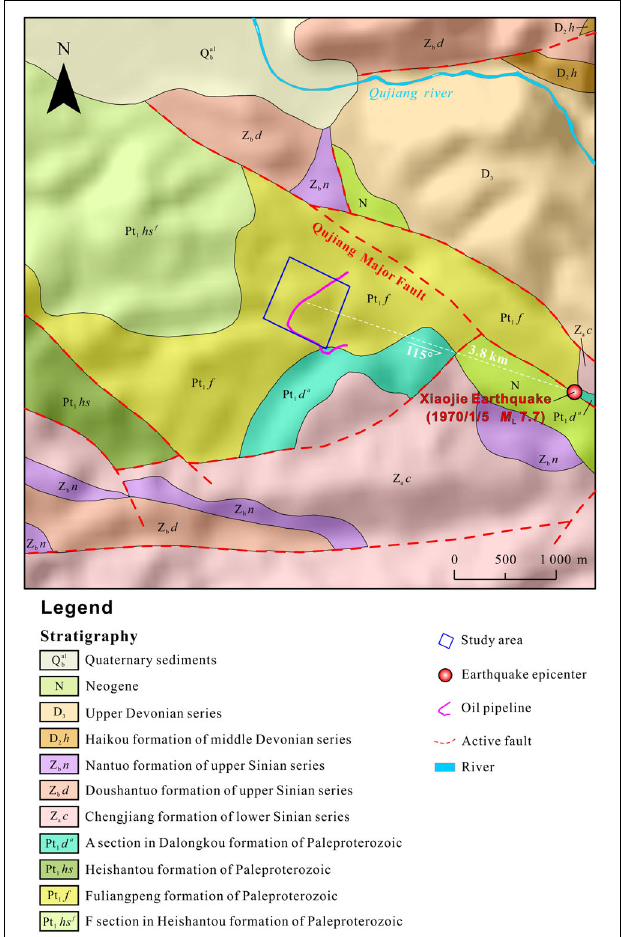
FIGURE 1 | Location map of the study area. (A) Location map of Sinopec oil pipeline in the study area and (B) Panorama of the study area. FIGURE 2 | Regional geological map of the study